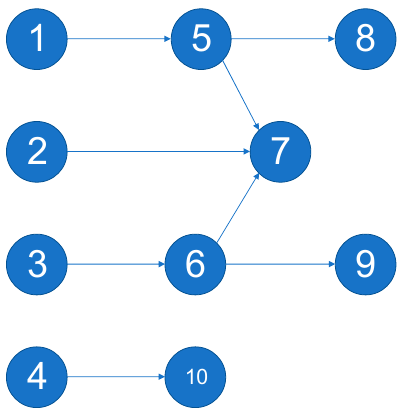
Figure 4. Projects’ dependencies.